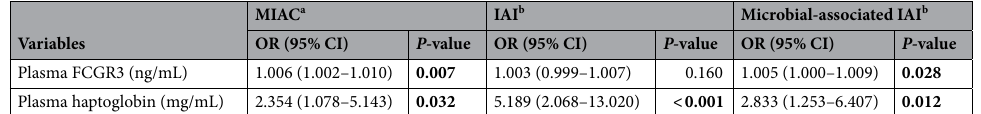
Table 3. Relationship of various plasma proteins with the presence of microbial invasion of the amniotic cavity (MIAC), intra-amniotic inflammation (IAI), and microbial-associated IAI, analyzed using multiple logistic regression. OR odds ratio, CI confidence interval, FCGR3A low affinity immunoglobulin gamma Fc region receptor III-A. a Adjustment for gestational age at sampling. b Adjustment for gestational age at sampling and parity. Significant values are in